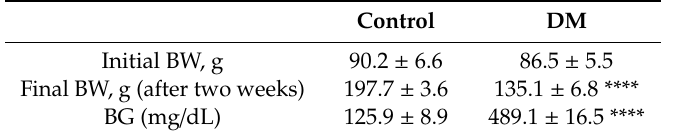
Table 1. Animal weights and biochemical characteristics in the studied